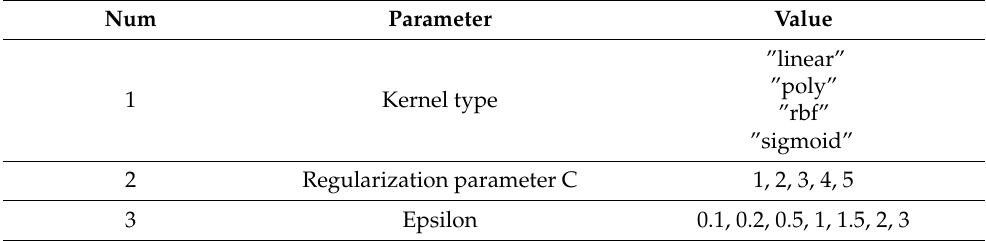
Table 5. Parameters for SVR